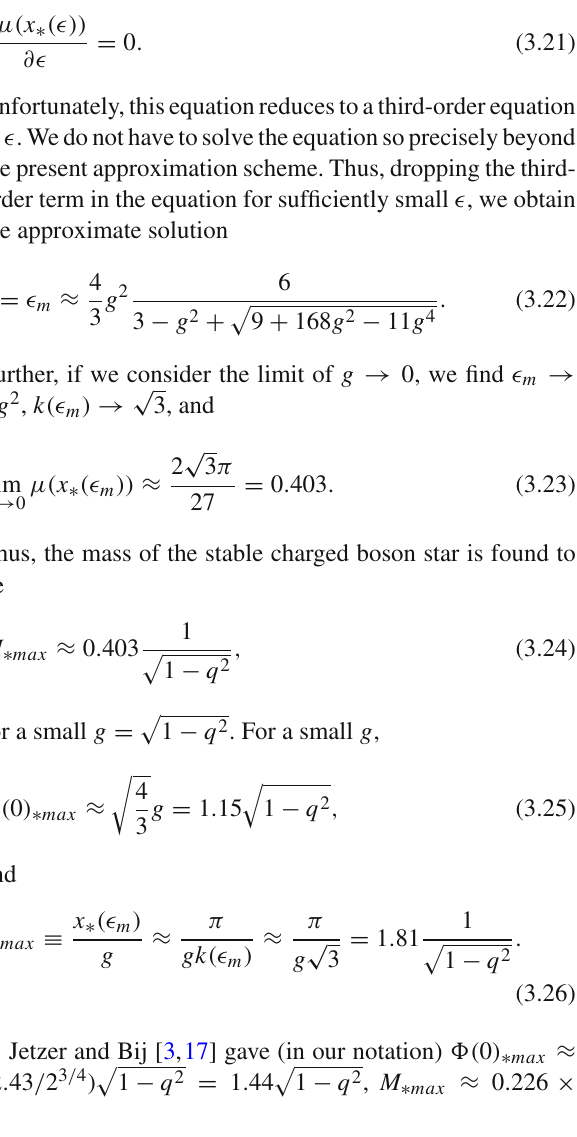
Fig. 3 Approximatechargedbosonstarmass M ∗ inunitsof √ (cid:14)φ( 0 ) for g = 0 . 1 , 0 . 2 , and 0 . 3 (from the as a function of (cid:15)( 0 ) = upper line to the lower line) for the case (cid:14) → ∞ . The dots indicate the numerical results in the large coupling